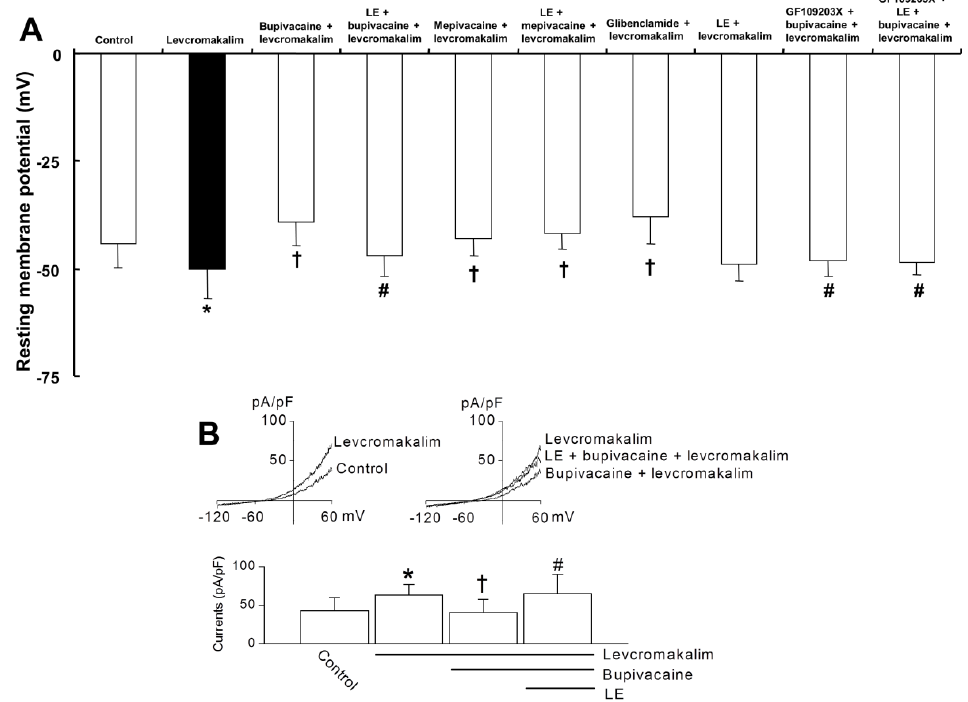
Figure 4. Effect of bupivacaine and lipid emulsion (LE) on membrane potential and whole-cell